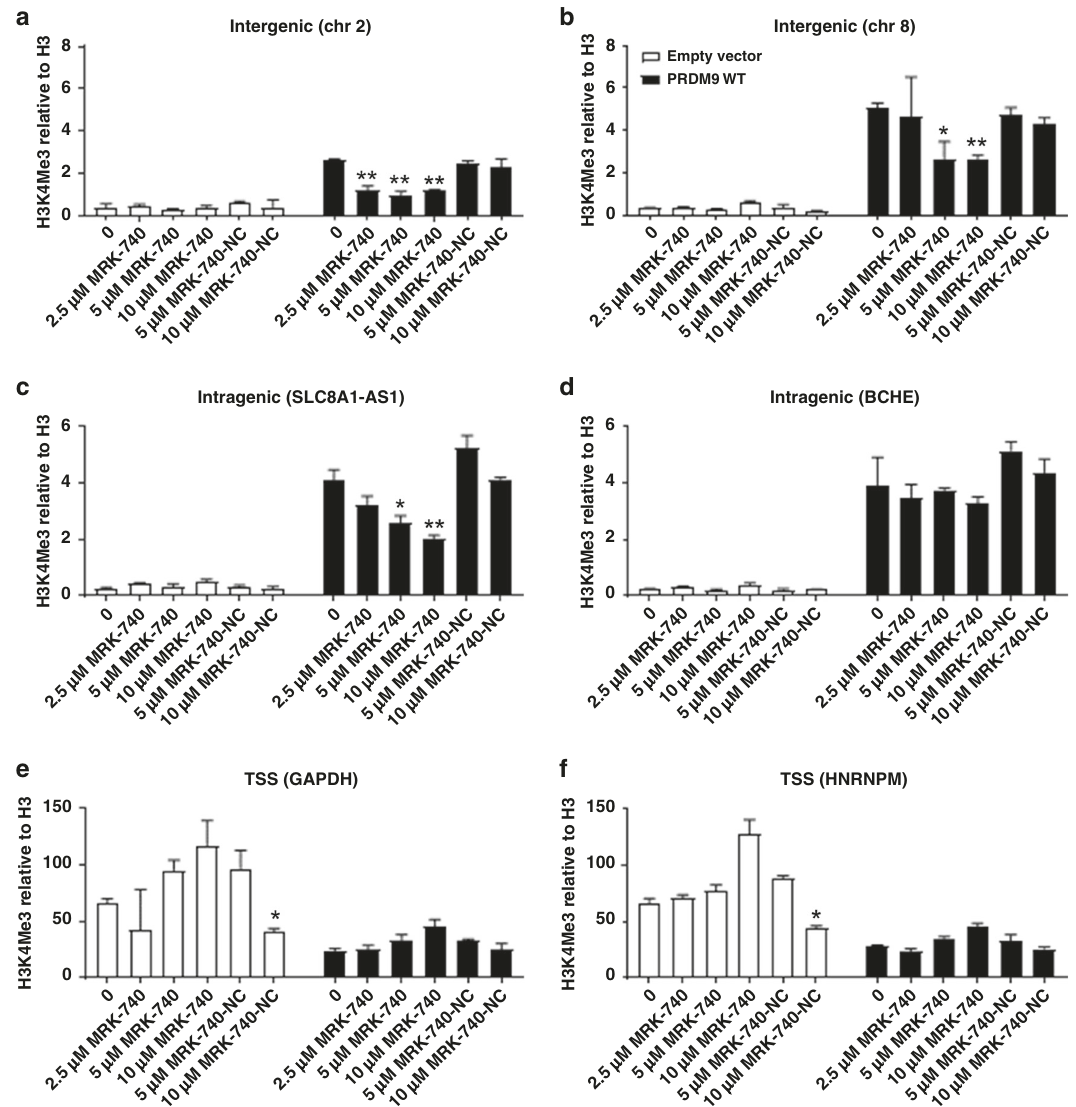
Fig. 7 Concentration-dependent inhibition of PRDM9-dependent H3K4 trimethylation using MRK-740. ChIP qPCR analyses of H3K4me3 methylation levels of known PRDM9-bound loci and control loci. Cells transfected with empty vector control, or a vector overexpressing wild-type PRDM9 were treated with DMSO, increasing concentrations of MRK-740 or MRK-740-NC. Concentrations used ( µ M) are indicated below each plot. ( a – d ) represent reported loci of PRDM9 methylation 26 ; ( e, f ) are transcriptional start sites (TSSs) which are not known loci of PRDM9 methylation. Data are normalized to total H3 and are presented as the mean ± upper and lower limits from two replicates. Representative plots of two independent experiments are shown in this fi gure. The coordinates and the genomic features associated with the assayed loci are indicated above each plot. Left Tailed Student's t -tests were performed by comparing DMSO (0 µ M) treated cells to compound treated cells that have been transfected with the same plasmids. * p -value < 0.05 and ** p -value < 0.01. Note that here we show a representative of two independent experiments (mean ± s.d of technical replicates) for our ChIP-qPCR experiments. Data obtained using this technique are inherently noisy due to stochastic differences in gene activity/histone positioning. Data are thus typically presented as representative rather than averaged. Source data are provided as a Source Data fi